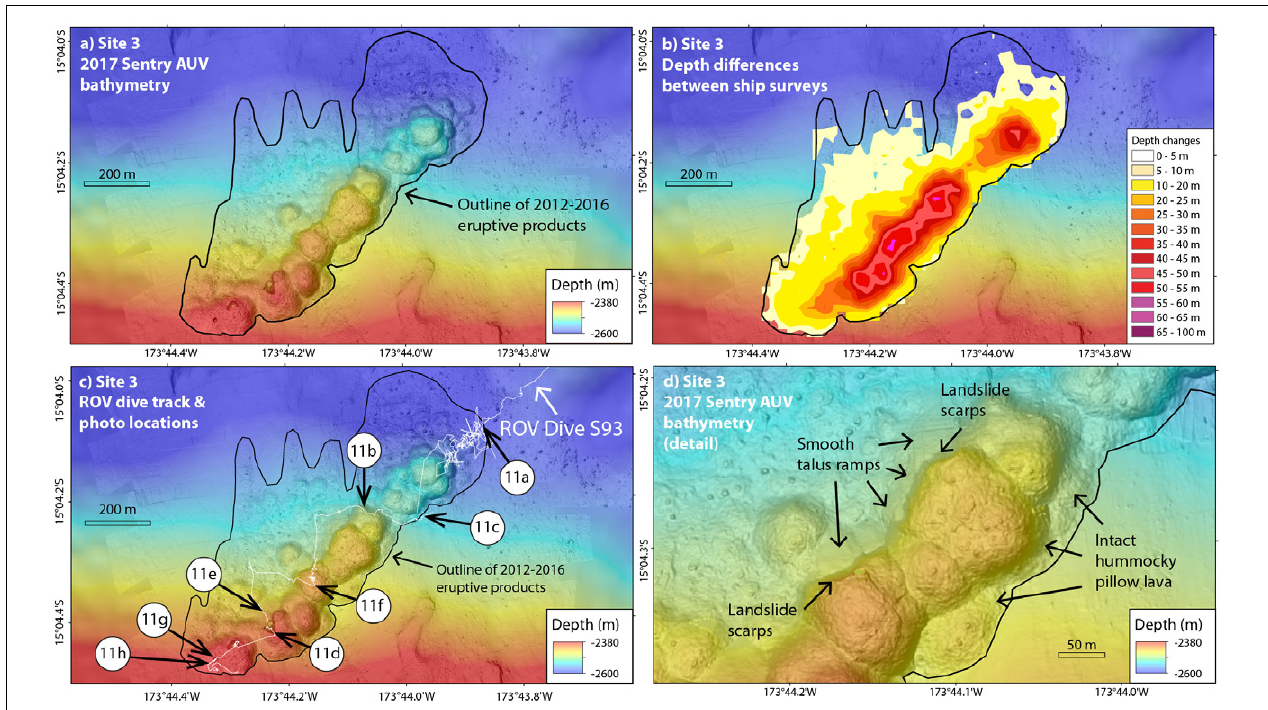
FIGURE 10 | Maps of eruption site #3, the pillow ridge on the NE flank of West Mata (see Figure 2 ) showing (a) post-eruption Sentry AUV bathymetry from 2017, (b) positive depth differences between ship-based surveys in 2012 and 2016 ( Table 2 ), (c) trackline of SuBastian ROV dive S93 (white line) on Sentry AUV bathymetry, with locations of images in Figure 11 (white numbered circles), and (d) close-up showing hummocky intact pillow lavas on the gentler upslope side of the ridge contrasting with smooth talus ramps below landslide scarps on the steeper downslope side. Black outlines enclose the site #3 eruption